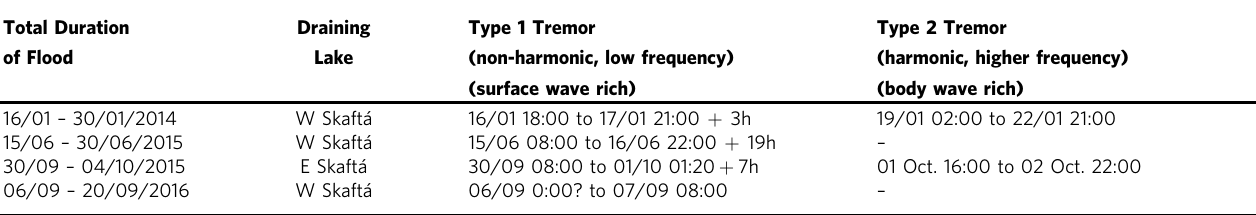
Table 1 Overview of total duration, the draining lake and the occurrence of Type 1 and Type 2 tremor during four fl oods from the eastern and western Skaftá cauldron in